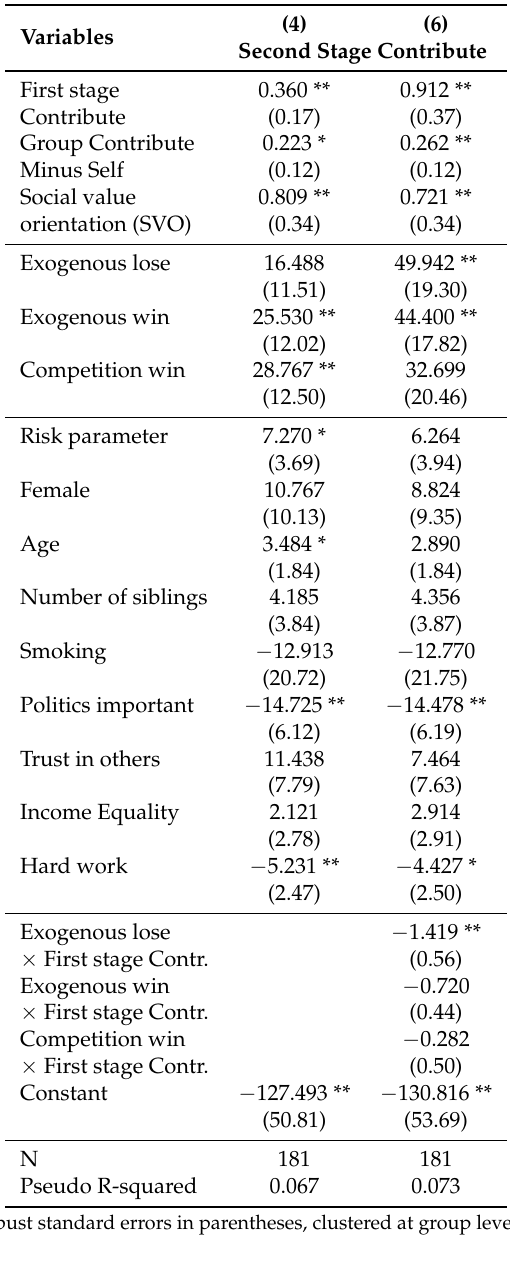
Table A5. Determinants of stage 2 contribution. Tobit model with limits at 0 and 100—Control